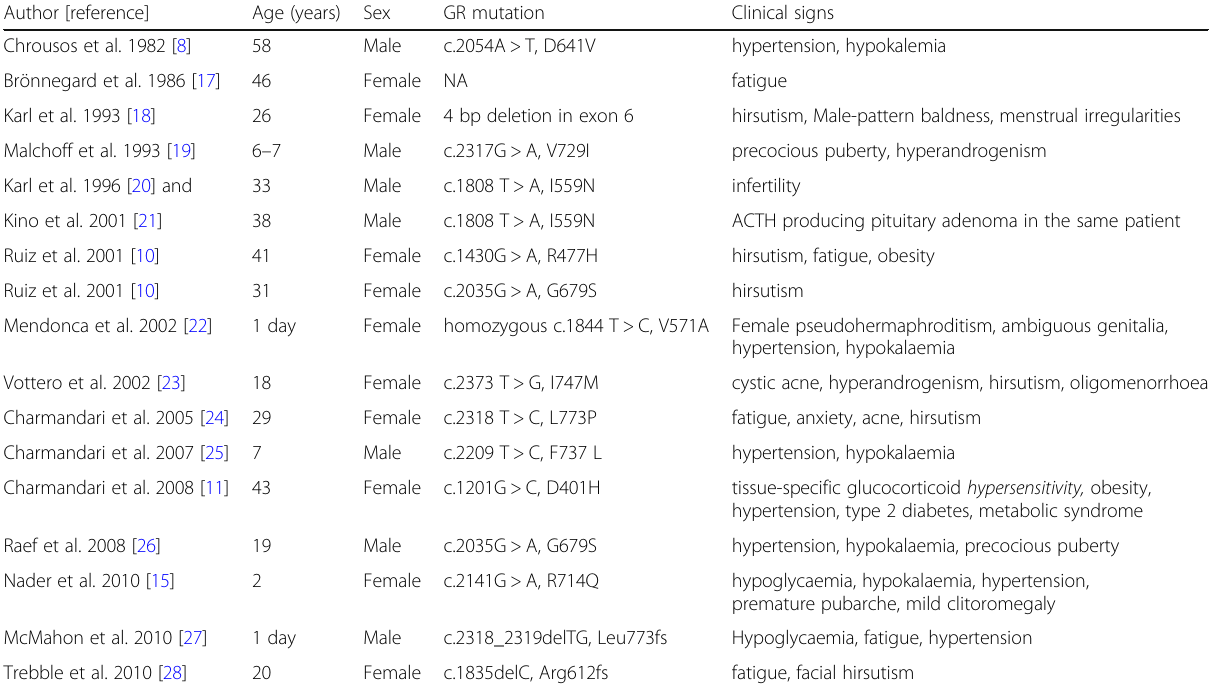
Table 2 Clinical signs of glucocorticoid resistance in previously reported